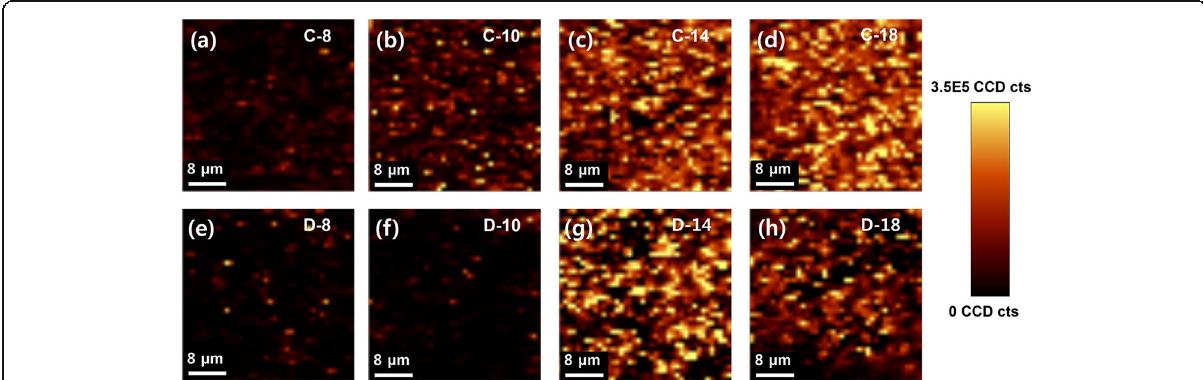
Fig. 5 Raman spectral images of a – d cross-AgNW films on the Au surface with different surface concentrations of AgNWs and e – h drop-casted AgNW films on the Au surface with corresponding surface concentrations. Surface concentration of AgNWs on Au substrate: a , e 4.7 μ g/cm 2 , b , f 5.9 μ g/cm 2 , c , g 8.3 μ g/cm 2 , and d , h 10.6 μ g/cm